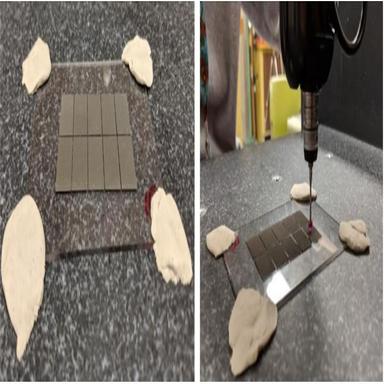
Thickness measurement setup for acquiring data for the working curve model: (a) Fixing a sample by securing four corners of the acrylic substrate with plasticine on the CMM granite table; (b) Measuring the thickness of a rectangle of a sample using the CMM probe.